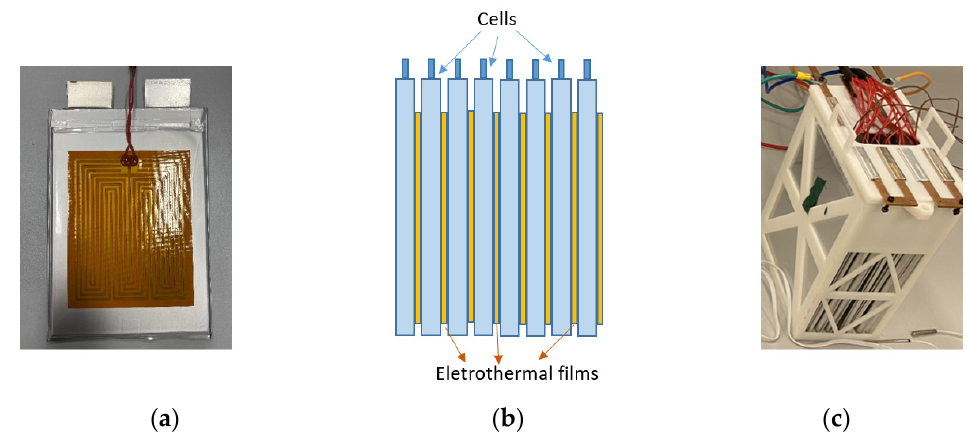
Figure 1. External heater. ( a ) Front view of the electrothermal film attached to the surface of a pouch cell; ( b ) side view sketch of a battery module with the cells and external heater in parallel connection; ( c ) battery module equipped with an external heater for experimental validation. Table 2. Electrothermal fi lm parameters.